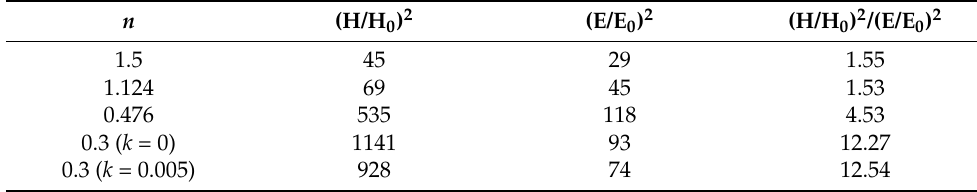
Figure 11. Field intensity distribution along the extrema of the hot spots for ( a ) electric and ( b ) magnetic components; ( c ) Poynting vector energy flux. Table 1. Comparative characteristics of hot spots of Janus